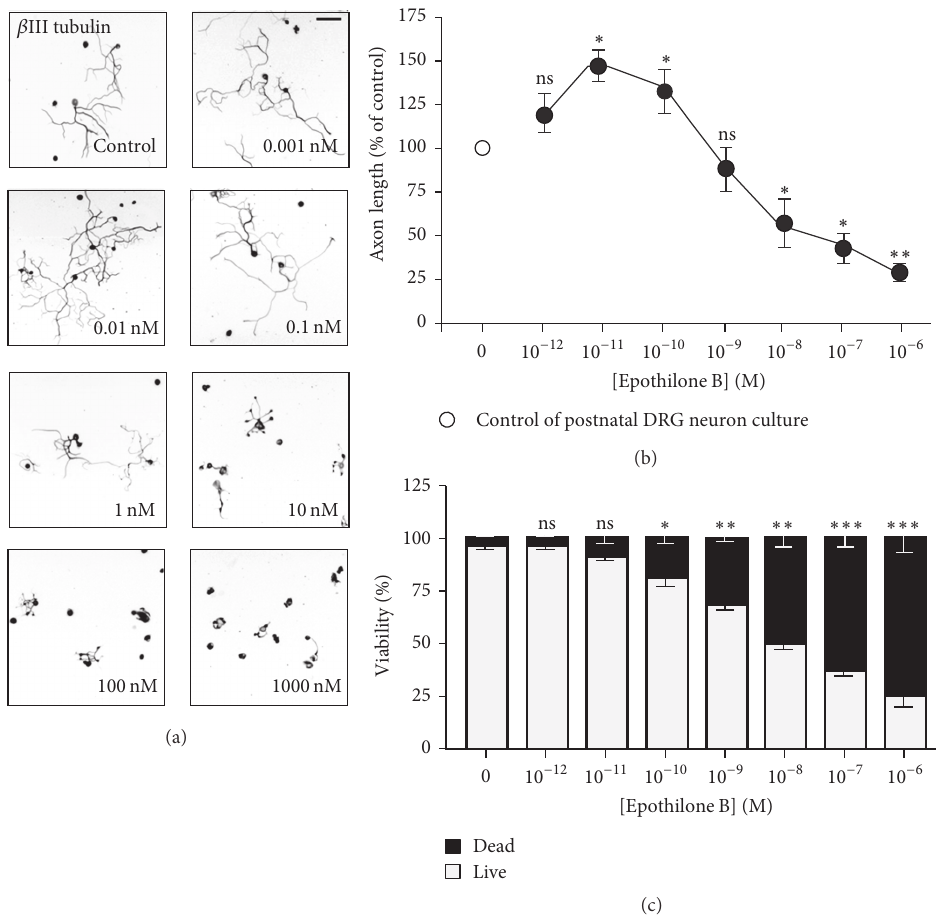
Figure 3: Effects of epothilone B on axon growth and cell viability in postnatal DRG neurons. (a–c) Postnatal day 4 (P4) DRG neurons were cultured in the absence or presence of various concentrations of epothilone B, from 1pM to 1 𝜇 M, as indicated. Neurons were fixed at 24 hr after plating and immunostained with anti-Tuj1 antibodies. Representative images ((a), inverted images from Tuj1 immunostaining) and quantification of axon length (b) are shown. Cell viability was assayed by PI staining (c). Scale bar, 100 𝜇 m. ∗ 𝑝 < 0.05, ∗∗ 𝑝 < 0.01, and ∗∗∗ 𝑝 < 0.001; ns, statistically not